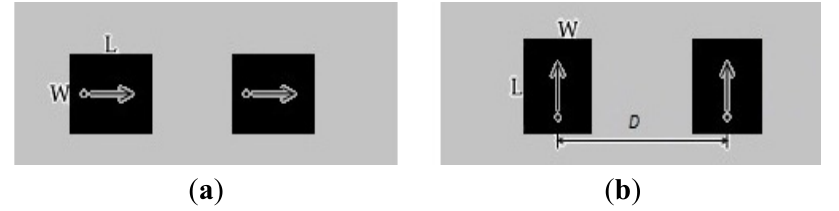
Figure 5. Probe fed microstrip antenna array ( a ) E-plane coupling; ( b ) H-plane coupling.